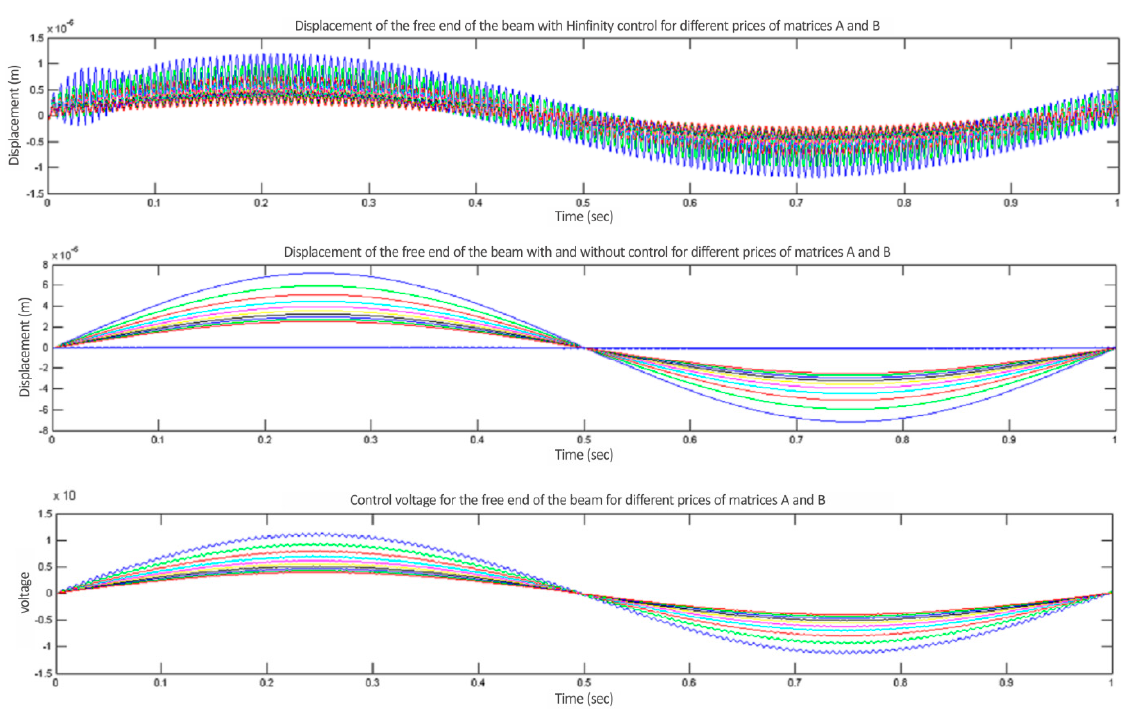
Figure 7. Results for matrices A and B with and without H in f , controlling for sinusoidal external inputs, at various prices.